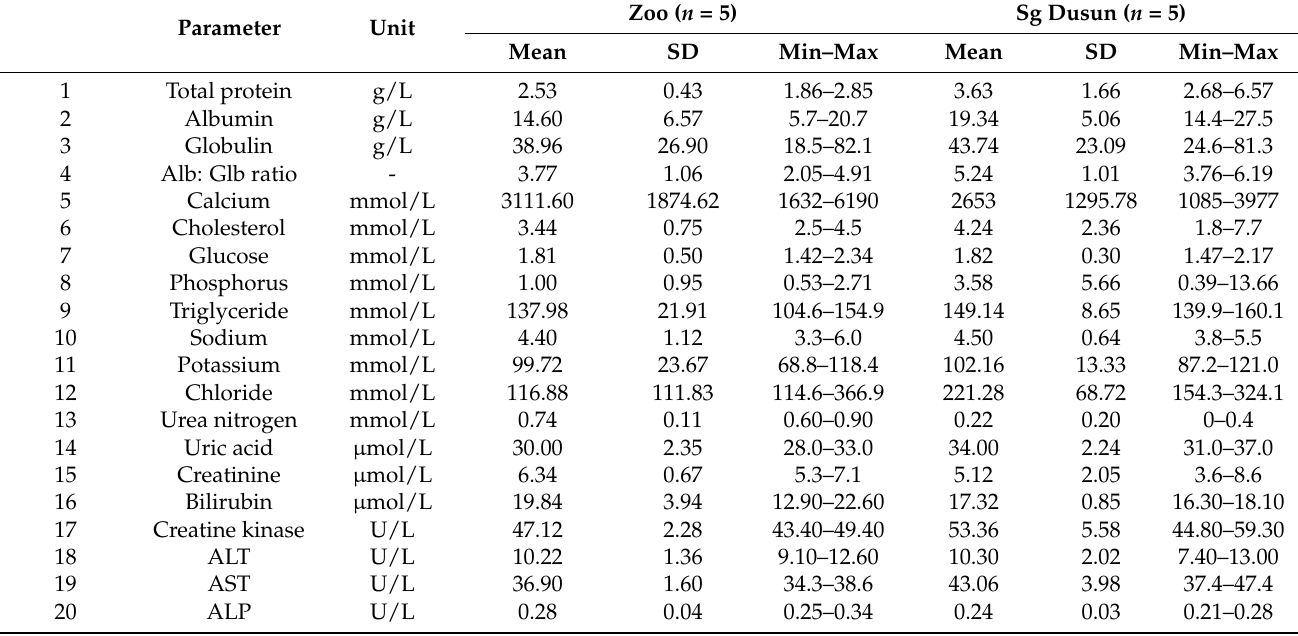
Table 8. Comparison of biochemical values, showing the parameters Mean, SD, and Range, between male and female captive false gharials in Peninsular